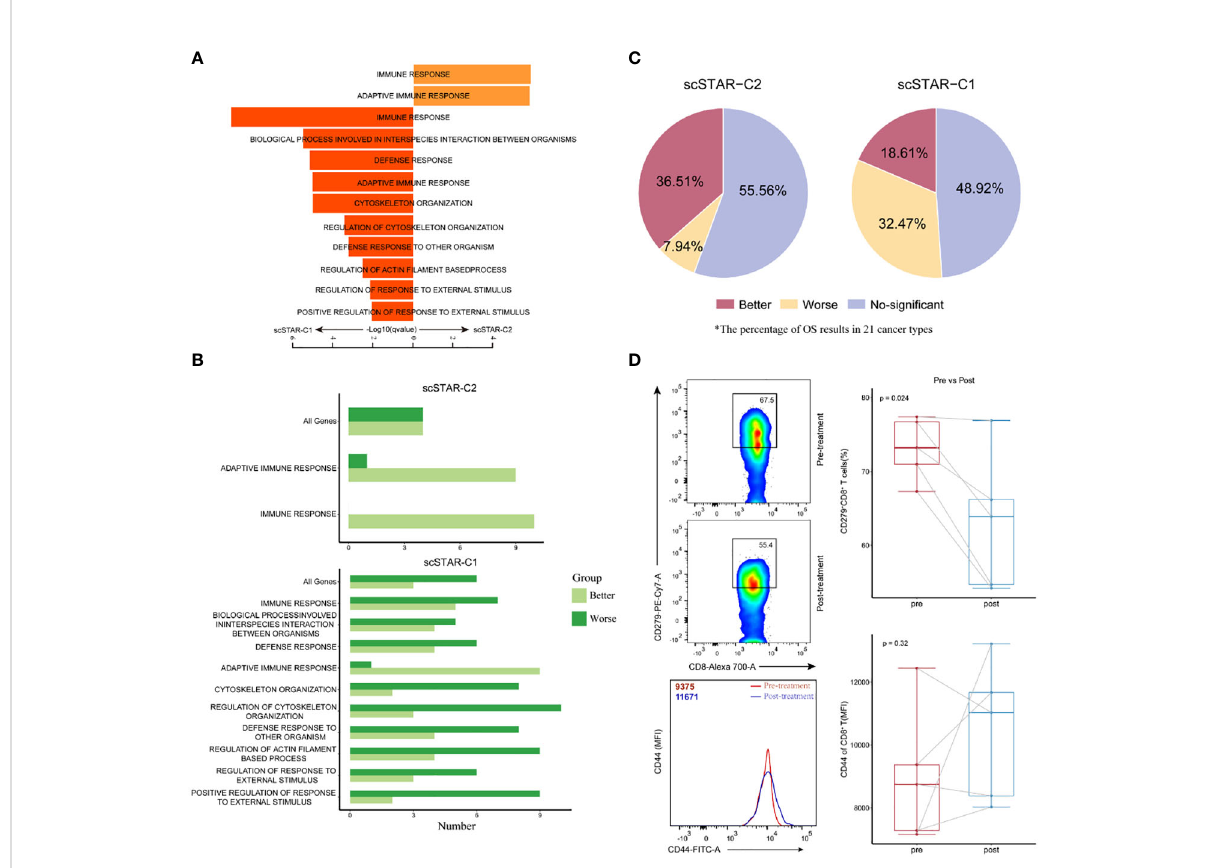
FIGURE 5 Molecular characteristics of CD8 + T after treatment is associated with improved overall survival. (A) Pathway enrichment analysis of genes in scSTAR-C1 and scSTAR-C2, respectively. The bar plot showed the top 10 enriched GO pathways. Benjamini-Hochberg (BH) adjusted p value < 0.05. (B) The number of associations between all changed genes, pathways in which scSTAR-C1 or scSTAR -C2 was involved and better or worse overall survival in the 21 tumor types. (C) The percentage of prognosis results predicted by scSTAR-C2 and scSTAR-C3 in 21 cancer types. (D) Flow cytometry analysis of the frequency of CD279 + CD8 + T cells (upper) and the quanti fi cation of CD44 protein level (below) for 5 paired samples, pre-gated on live/CD3+ T cells and live/CD3+/CD8+ T